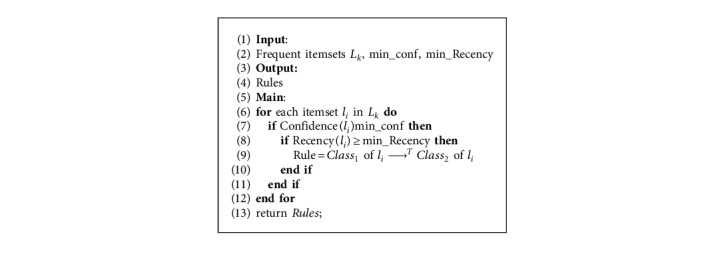
 Rules generation.